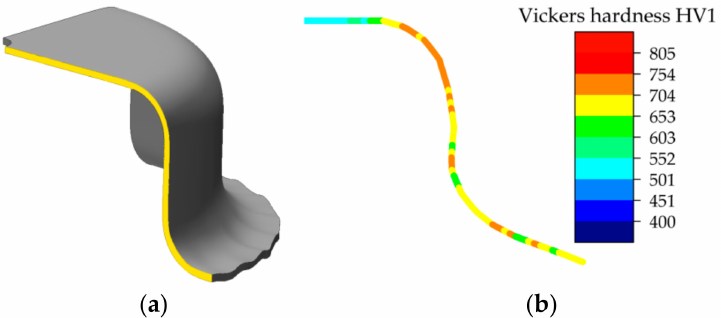
Figure 5. ( a ) Exemplary illustration of the area for hardness measurement on a cut cup, ( b ) Hardness curve HV1 of X46Cr13 after austenitization at 1150 ◦ C for 120 s and subsequent forming at 900 ◦